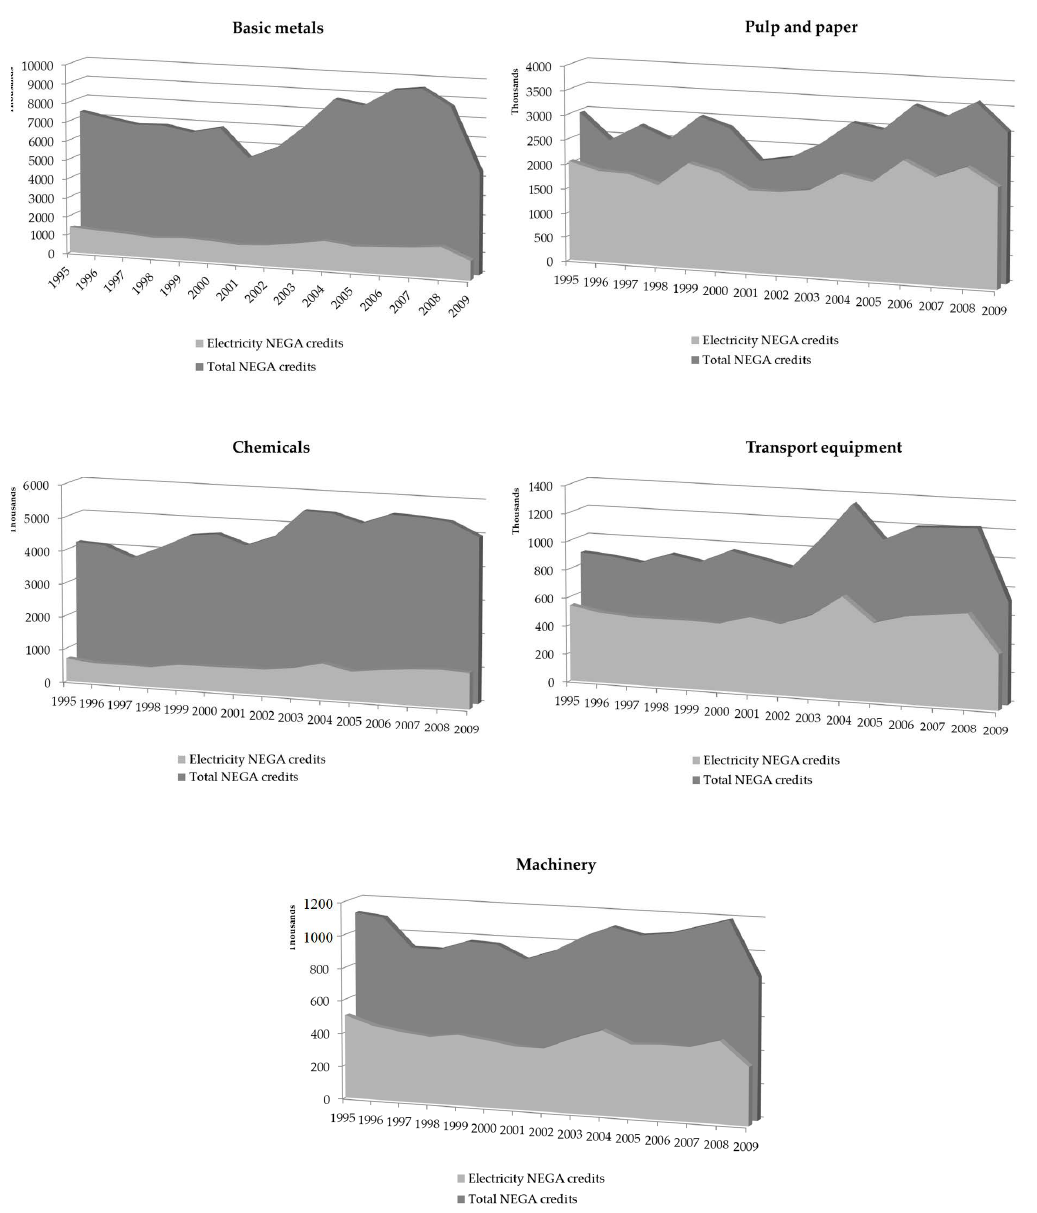
Figure 7. Total NEGA credits in the exports of the Swedish manufacturing sectors, of which NEGA credits derived from the electricity consumption (in tons of CO 2 ).